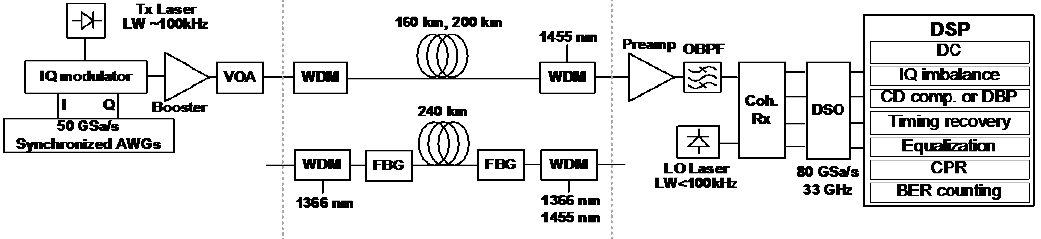
Figure 1. Experimental set-up of a 28-Gbaud Nyquist-shaped optical 64-quadrature amplitude modulation (QAM) signal (left), transmission line with Raman amplification schemes for each distance (middle), and receiver with DSP schematic (right).